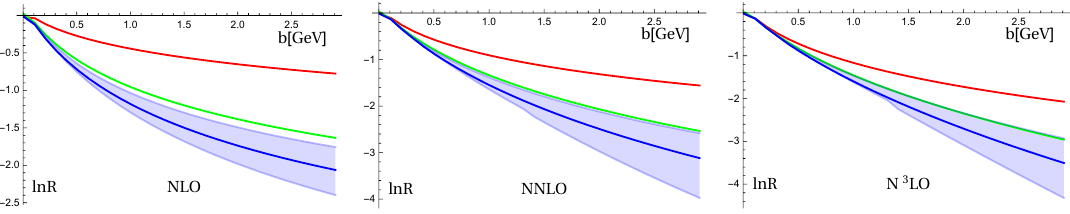
) ! ( (cid:22) b ; (cid:22) 2 )) where (cid:22) b = C 0 =b + 2. Z b